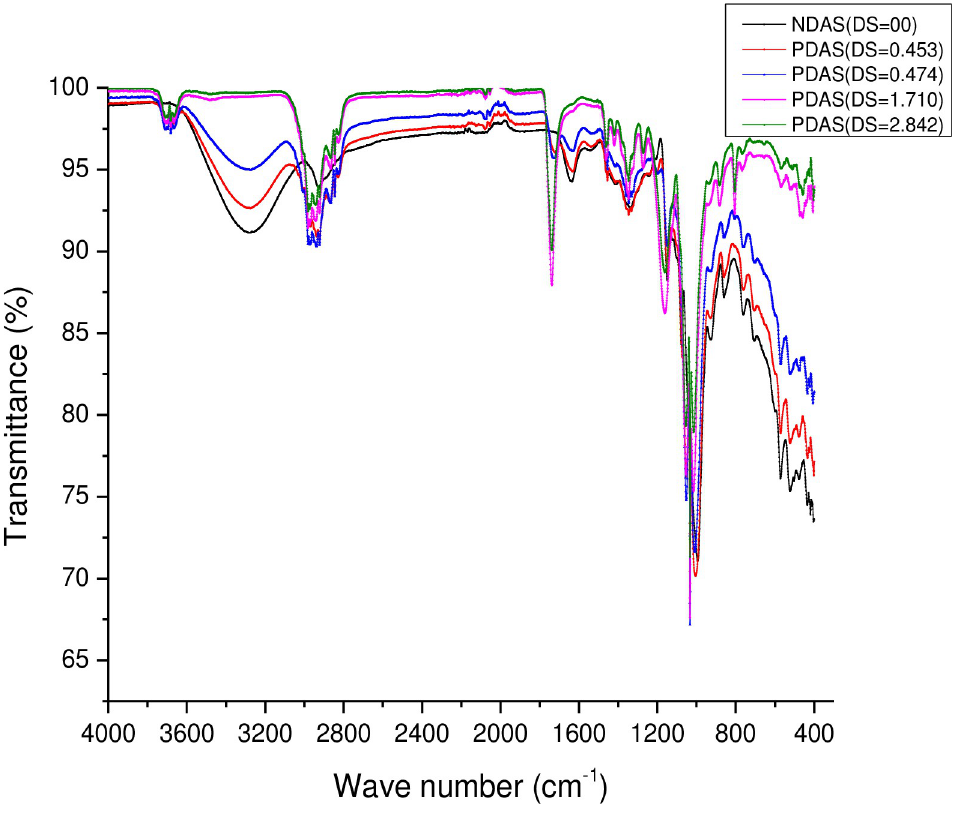
Fig 2. Fourier Transform Infrared (FTIR) spectra of NDAS and PDAS with different